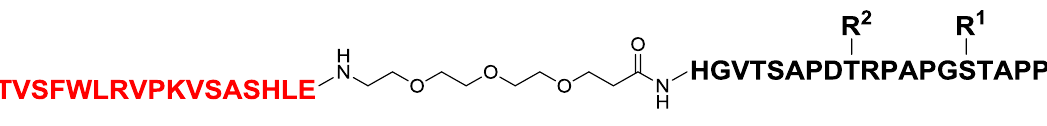
Figure 2. Li’s vaccine consisting of the glycopeptide antigen and the T-cell epitope